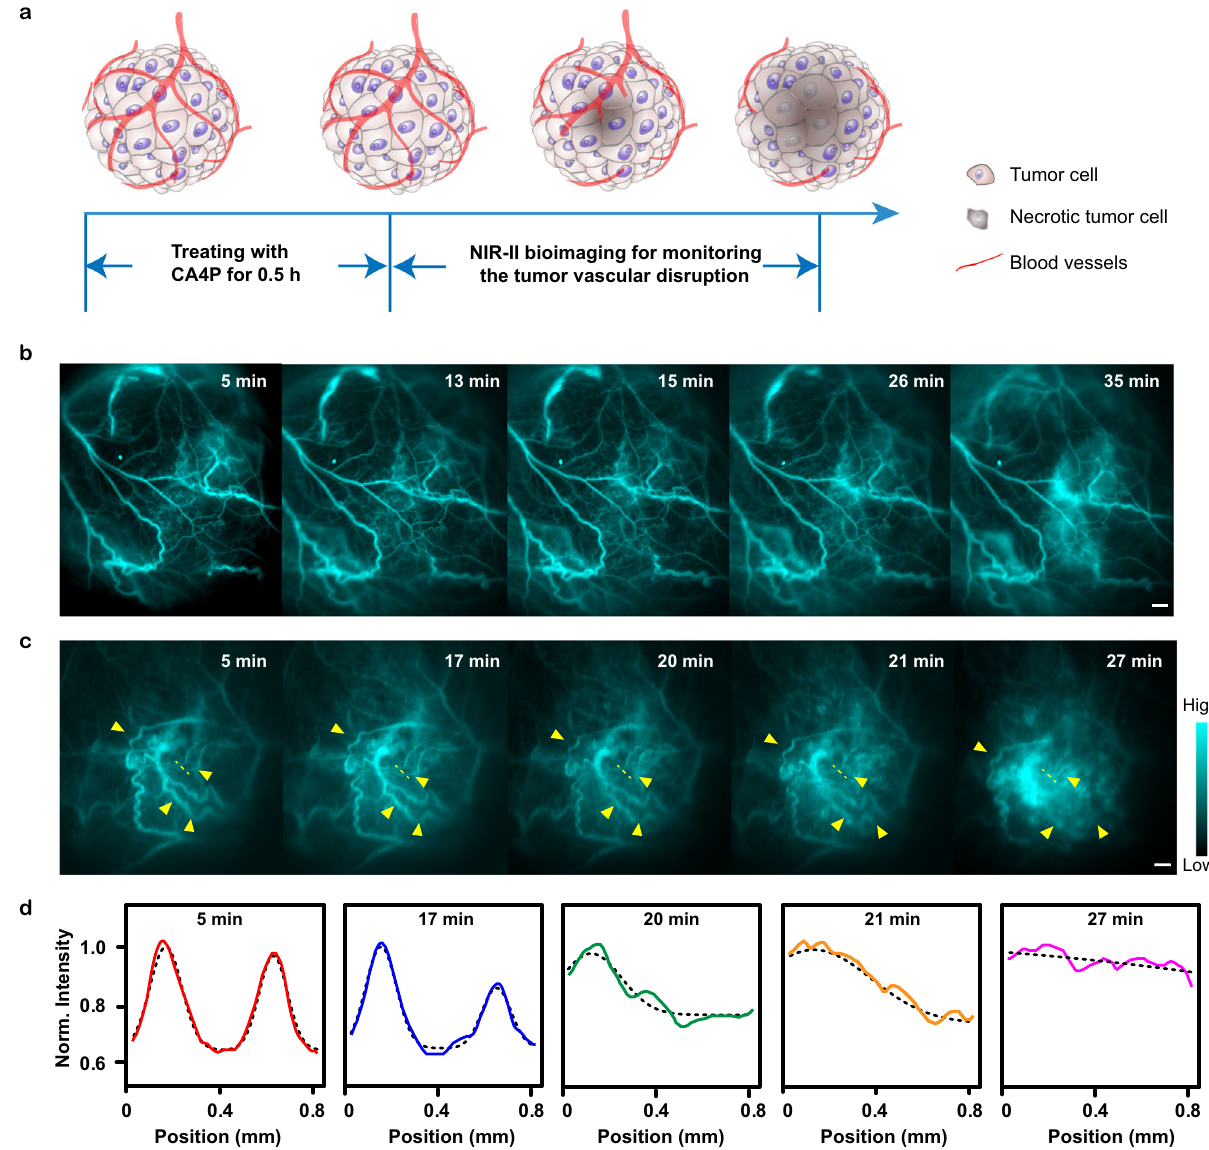
Fig. 6 Real-time monitoring of the tumor vascular disruption after treatment with combretastatin A4 phosphate (CA4P). a Schematic illustration of the tumor vascular disruption process after treatment with CA4P. b After 30 min administration of PBS, tumor vasculatures NIR-II imaging of nude mice with 143B xenograft osteosarcoma were obtained at different time points after FT-TQT@FBS p.i. c After 30 min administration of CA4P, tumor vasculatures NIR-II imaging of nude mice with xenograft osteosarcoma 143B was obtained at different time points after FT-TQT @FBS p.i. d Cross-sectional (solid line) and Gaussian fi t fl uorescence intensity pro fi les (dotted black line) of the vessel along the dashed yellow lines in c at different time points. Scale bar: 1 mm. Norm, Normalized. The detailed imaging parameters for each image are listed in Supplementary Table